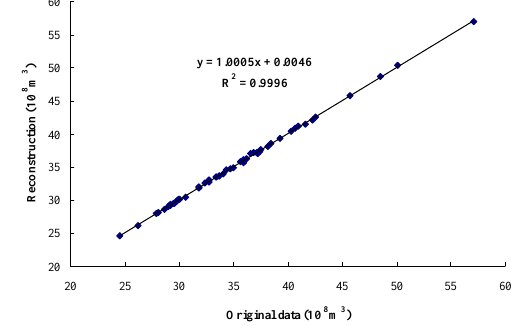
Figure 8. The correlation between the reconstruction of AR time series based on EEMD and its original